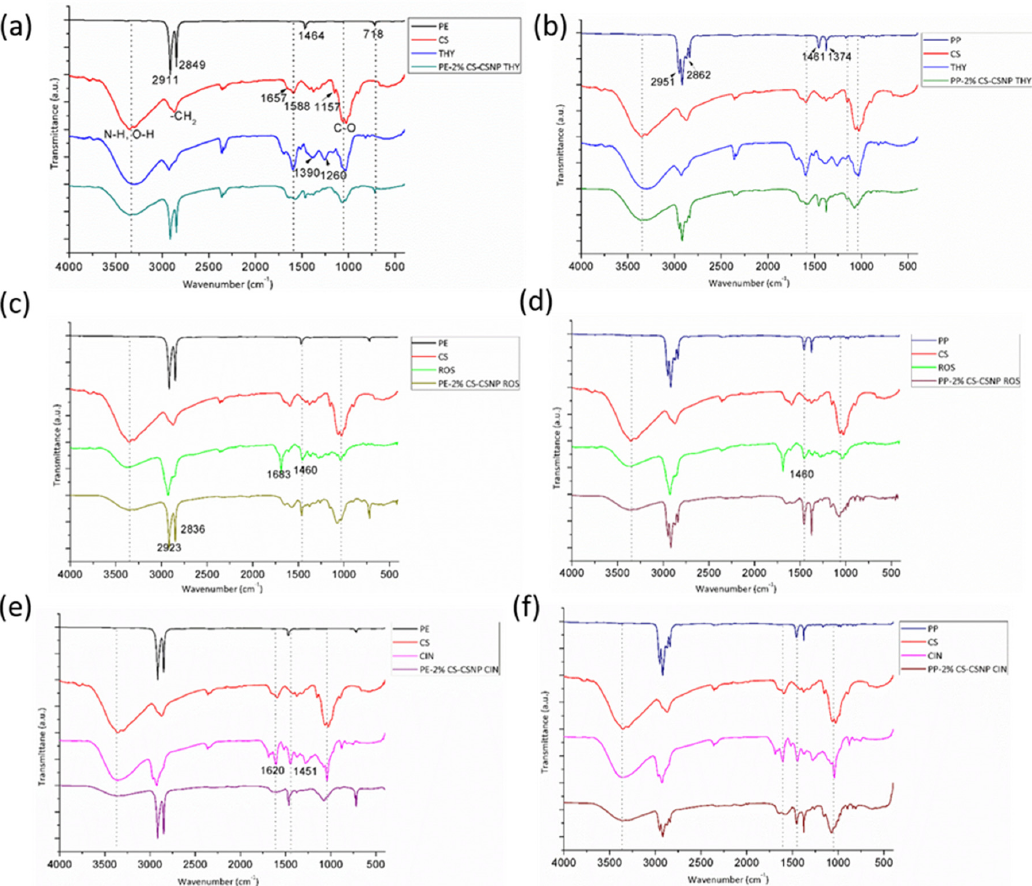
Figure 1. ATR-FTIR spectra of the pure polyethylene (PE), polypropylene (PP), chitosan (CS), and individual antioxidants, together with the applied formulation of thyme onto PE ( a ) and PP foil ( b ), rosemary onto PE ( c ) and PP foil ( d ); and cinnamon onto PE ( e ) and PE ( f ) foil.